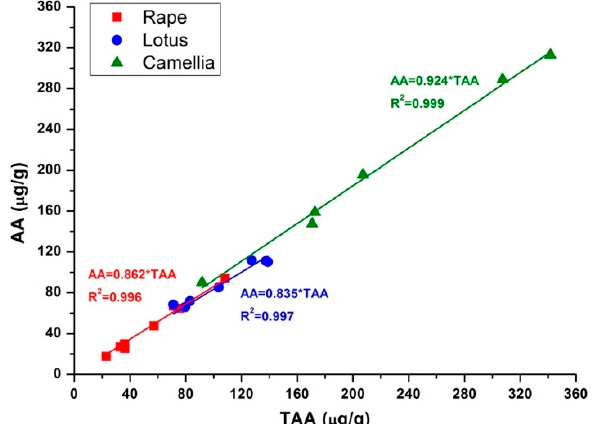
Figure 5. Plots of AA vs. TAA in the investigated bee pollen samples. Linear equation and correlation coefficient ( R 2 ) were presented.